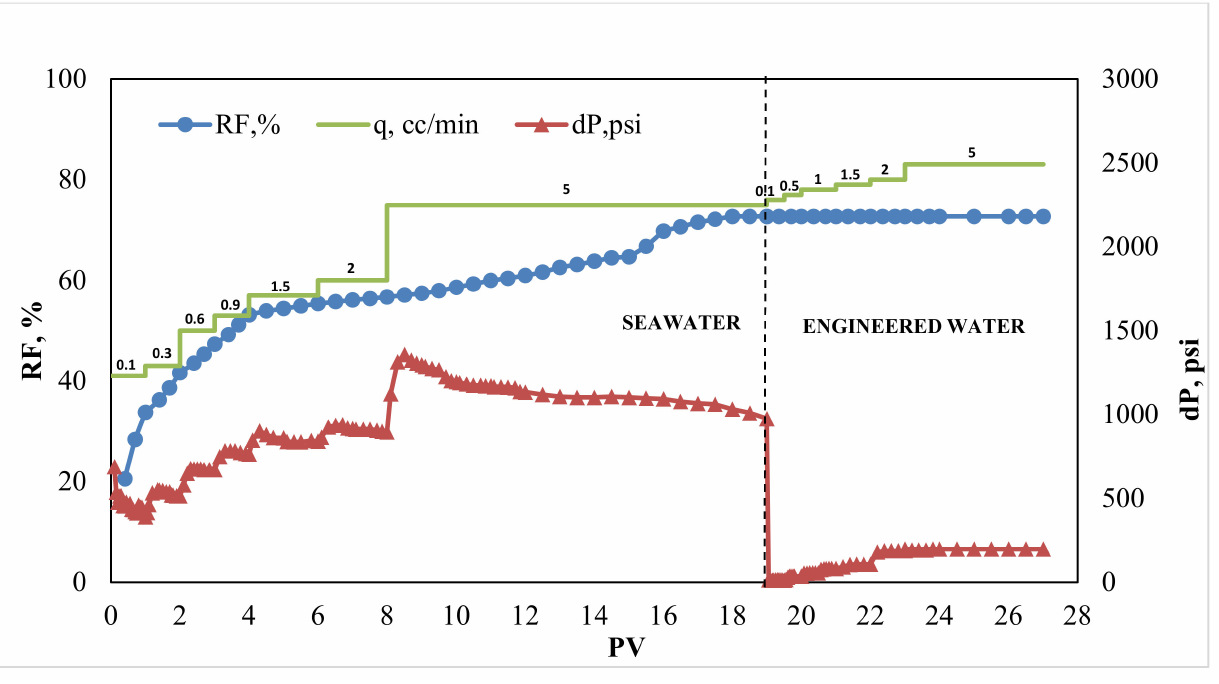
Figure 4. Engineered water (EW1) injection core flooding results (5 × Diluted CSW with 2Ca ∗ 2SO 4